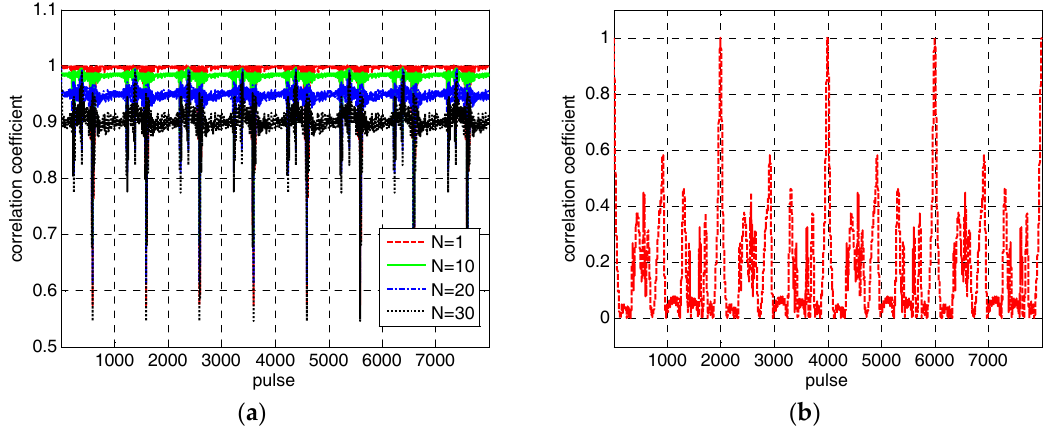
Figure 2. The correlation coefficients of the simulation data. ( a ) The correlation coefficients at different accumulation numbers. ( b ) The corrcetion coefficients between the first range profile and others.